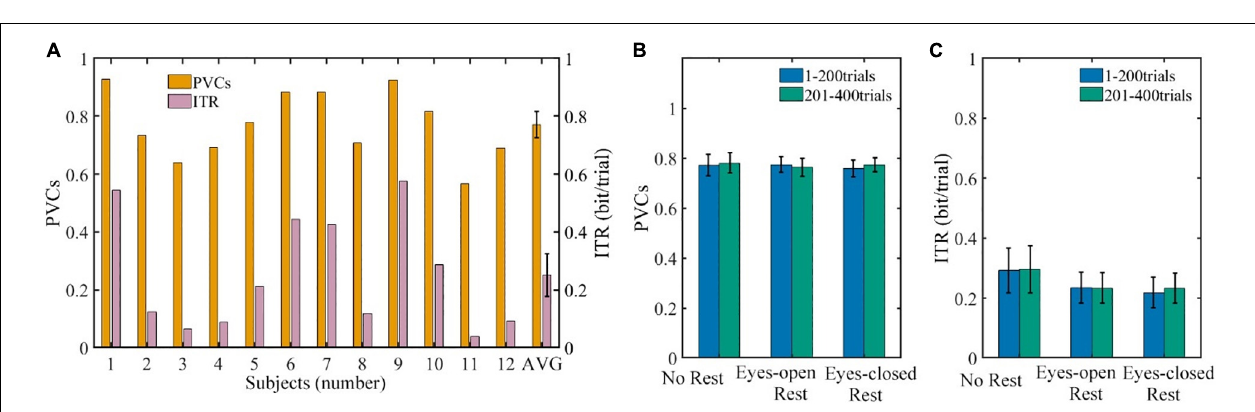
FIGURE 3 | The results of the questionnaire (scores after experiment minus scores before). (A) The SSSQ (0–5 each state) score variations after the experiment. (B) The MFI-20 (0–20 each state) score variations after the experiment. Error bars indicate the standard error of mean (SEM) scores. ∗ p ≤ 0.05. SSSQ, short stress state questionnaire; MFI, multidimensional fatigue inventory.